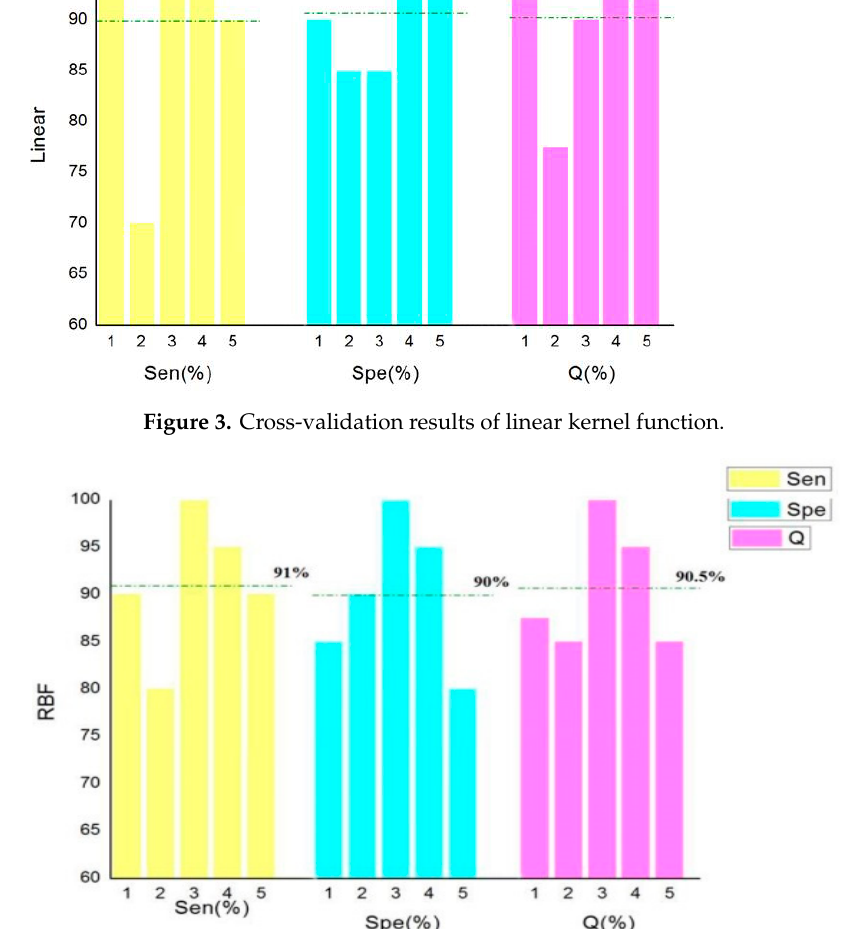
Figure 5. Cross-validation results of polynomial kernel function.